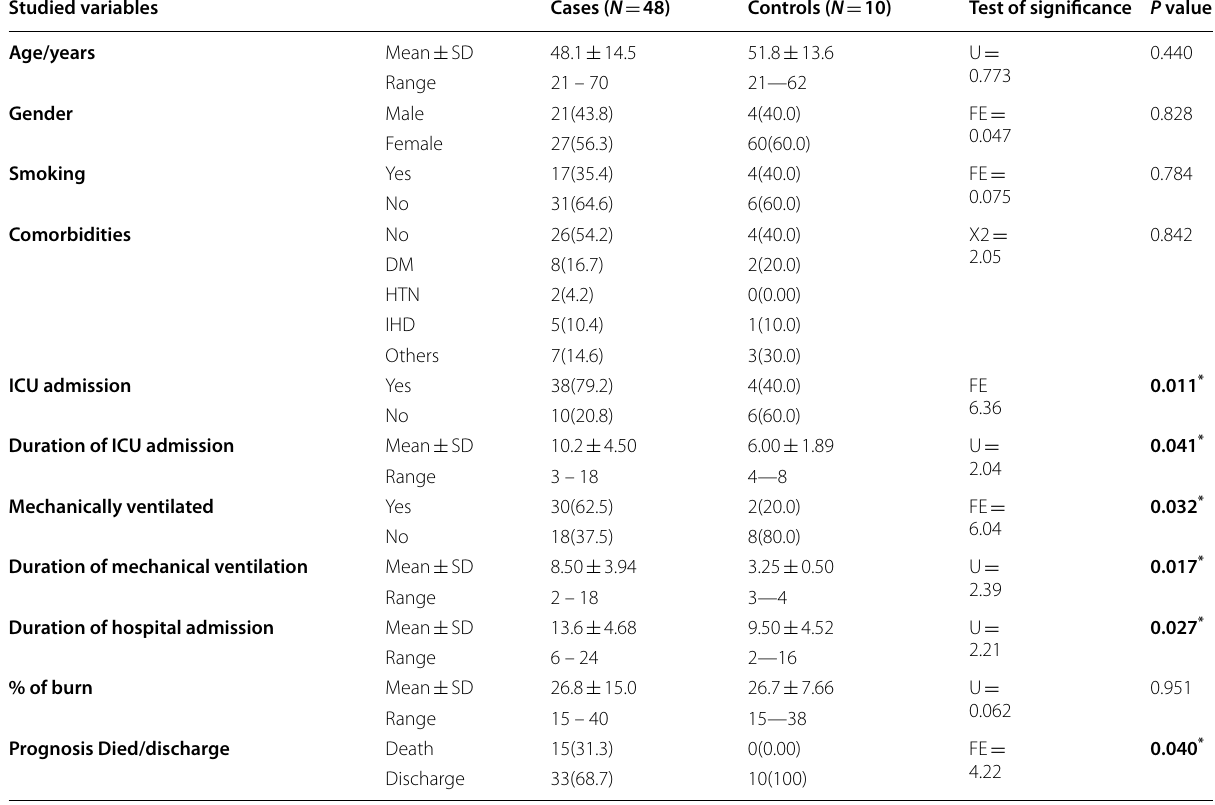
Table 2 Demographic data of the studied